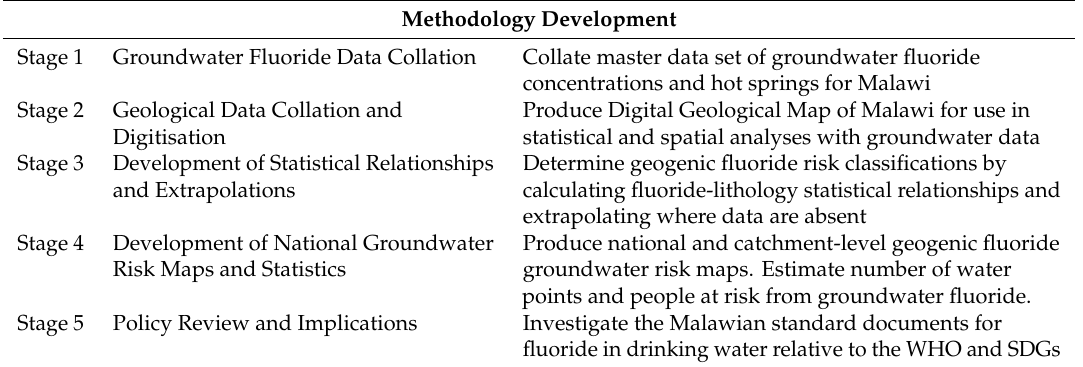
Table 1. Summary of methodology development, per stage, with a short description of the objectives of each